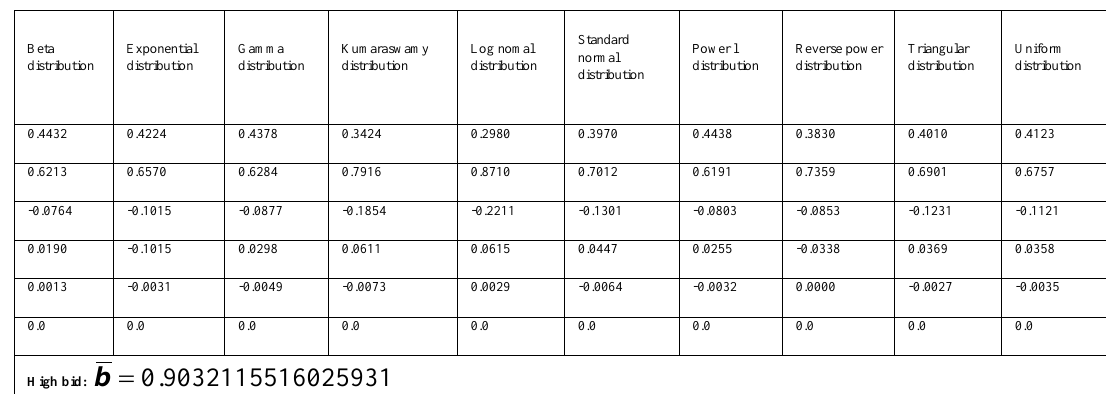
Table 2 Solution: Chebyshev coeff. of K=15 order reserve price =0.5